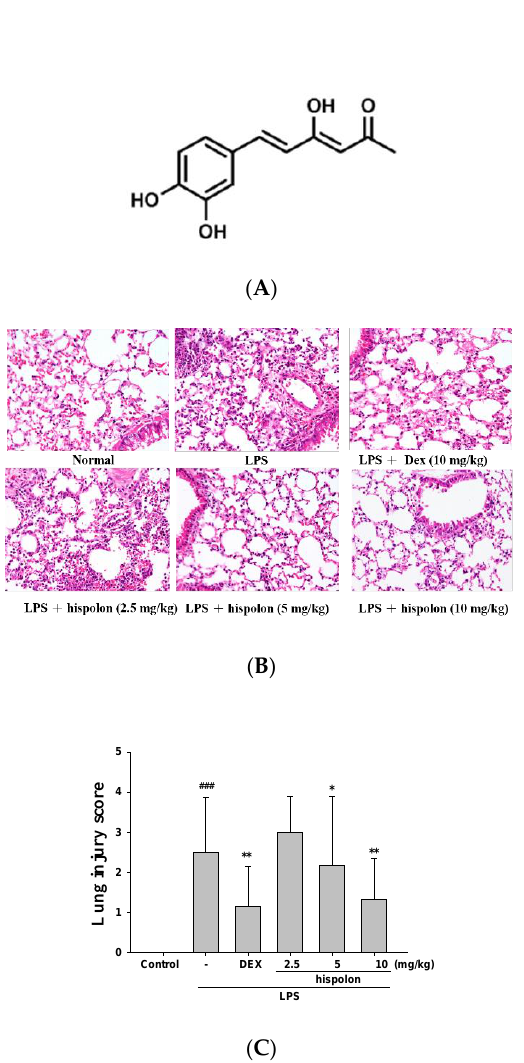
Figure 1. ( A ) The chemical structural formula of hispolon, ( B ) the lung injury scores and ( C ) the e ff ects of hispolon (2.5, 5 and 10 mg / mL) on LPS-induced histopathologic alterations in lung tissues of mice. After LPS challenge, the lungs were prepared for histological assessment. Sections were stained with H&E and viewed under magnification (400 × ). Data are presented as the means ± S.E.M (n = 6). ### p < 0.001 versus the control group. * p < 0.5 and ** p < 0.01 versus the LPS